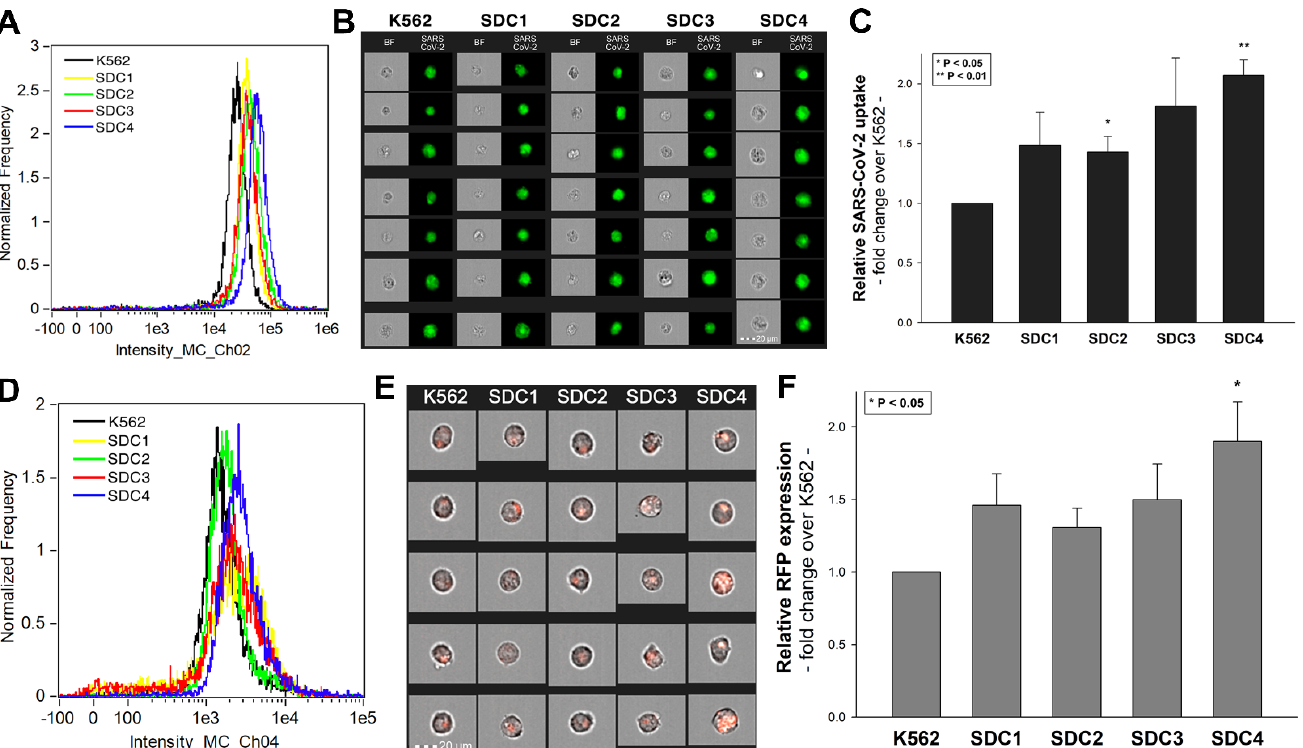
Figure 1. Cellular entry of SARS-CoV-2 into SDC transfectants. WT K562 cells and SDC transfectants were incubated with heat-inactivated SARS-CoV-2 (at 1 MOI) for 18 h at 37 °C. After incubation, the cells were washed, trypsinized, fixed, permeabilized and treated with antibodies specific for the spike glycoprotein (along with secondary AF 488-labeled antibodies). Cellular uptake of SARS-CoV-2 was then analyzed with imaging flow cytometry and confocal microscopy. ( A ) Representative flow cytometry histograms showing the intracellular fluorescence of SARS-CoV-2-treated WT K562 cells and SDC transfectants. ( B ) Brightfield (BF) and fluorescent cellular images of SARS-CoV-2-treated WT K562 cells and SDC transfectants. Scale bar = 20 μm. ( C ) Detected fluorescence intensities were normalized to SARS-CoV-2-treated WT K562 cells as standards. The bars represent the mean ± SEM of four independent experiments. Statistical significance vs. stand- ards was assessed with analysis of variance (ANOVA). * p < 0.05; ** p < 0.01. ( D – F ) Contribution of SDCs to SARS-CoV-2 PSV-mediated gene transduction. WT K562 cells and stable SDC transfectants were incubated with 1 × 10 5 transducing units of SARS-CoV-2 PSV-RFP. RFP expression was analyzed 72 h later with imaging flow cytometry. ( D ) Representative flow cytometry histograms showing RFP fluorescence of WT K562 cells and SDC transfectants, following 72 h incubation with SARS-CoV-2 PSV. ( E ) Cellular images of SARS-CoV-2 PSV-treated WT K562 cells and SDC transfectants as detected with imaging flow cytometry. Scale bar = 20 μm. ( F ) Detected cellular RFP intensities were normalized to SARS-CoV-2 PSV-treated WT K562 cells as standards. The bars represent the mean ± SEM of four independent experiments. Statistical significance vs. standards was assessed with ANOVA. * p < 0.05.